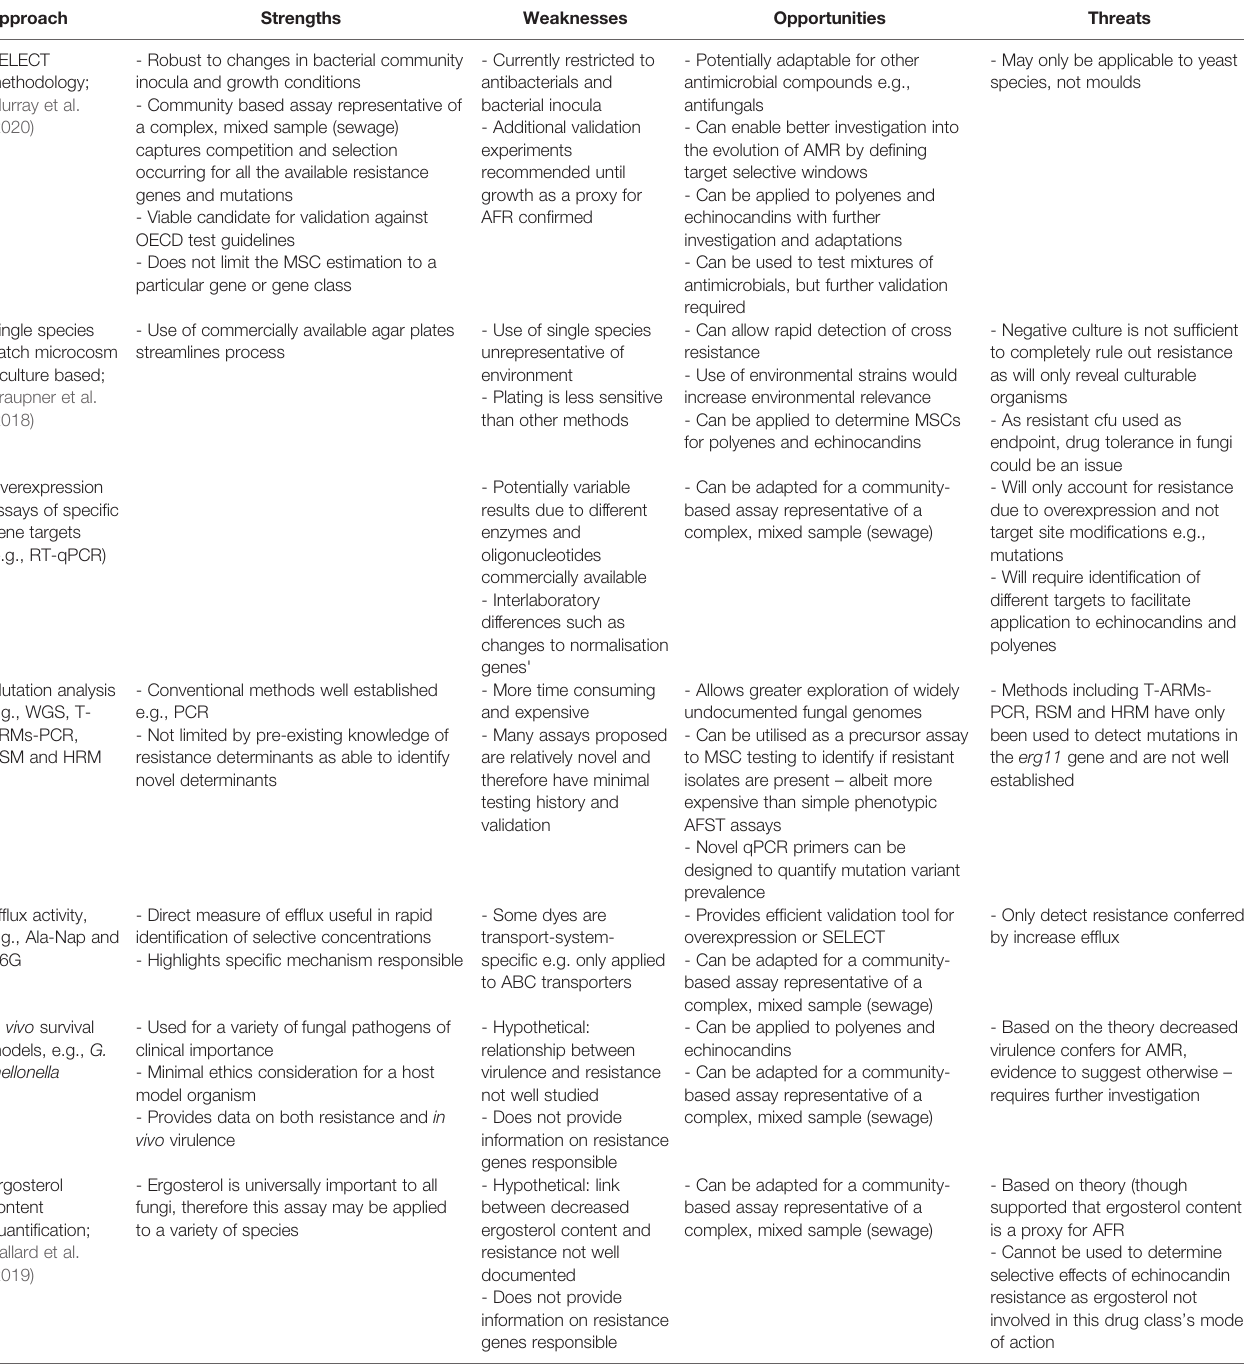
TABLE 1 | Strengths, weaknesses, opportunities and threats (S.W.O.T) analysis of proposed assays [adapted from Murray et al. (2021)].